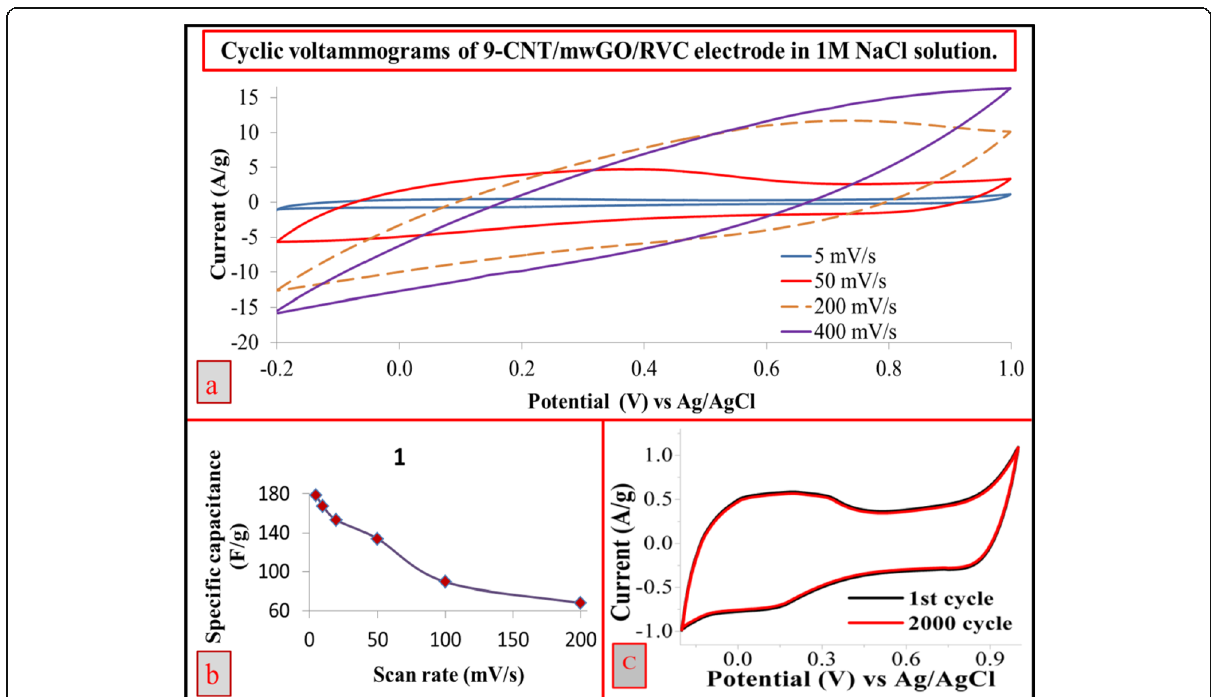
Fig. 4 a CV and b specific capacitance at various scan rates and c the cyclic stability scanned at 20 mV/s using 9-CNT/mwGO/RVC